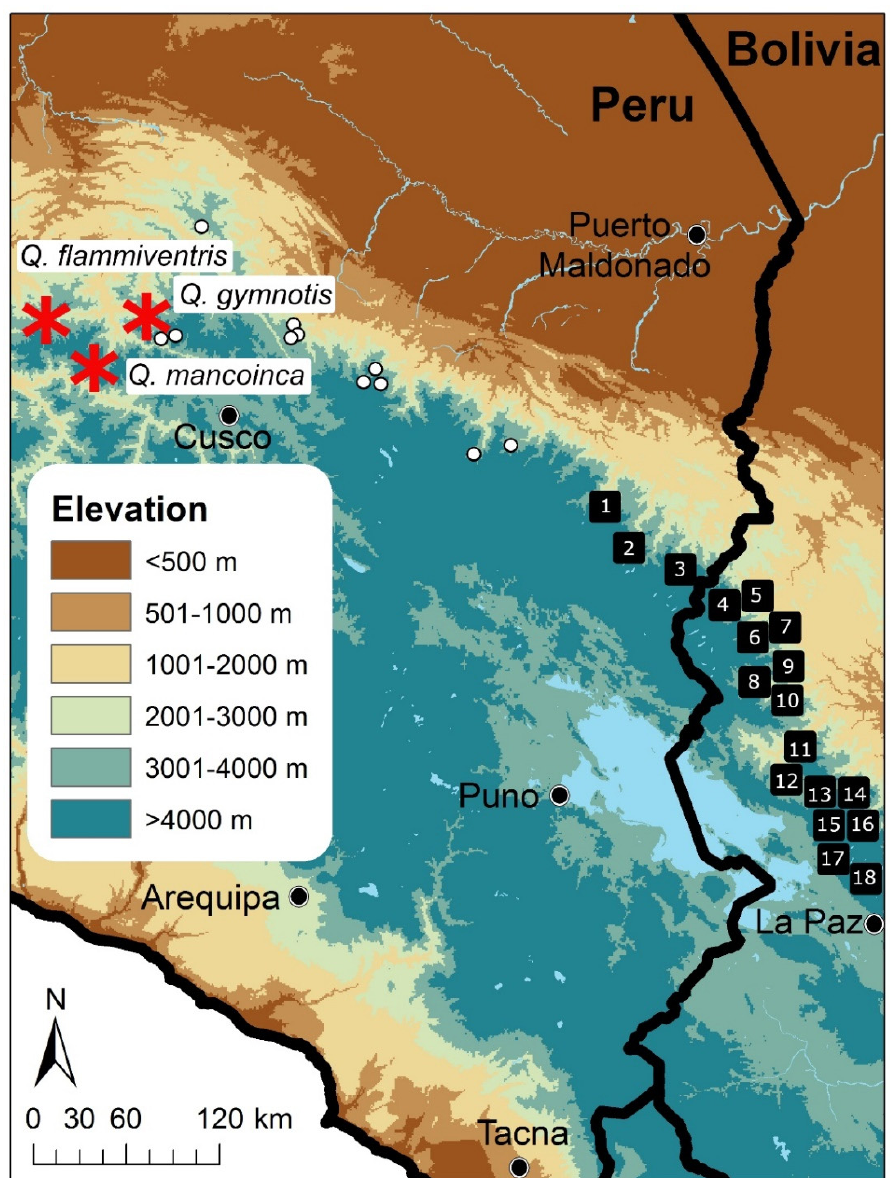
Figure 3. Type localities of frogs in the genera Bryophryne (white circles, species details not shown), Microkayla (squares) and Qosqophryne gen. n. (red asterisks) in southern Peru and northern Bolivia. The known distribution range of these frogs is limited to the type locality and immediate surroundings. For species of Microkayla : (1) M. boettgeri ; (2) M. chilina ; (3) M. chapi ; (4) M. katantika ; (5) M. chaupi ; (6) M. melanocheira ; (7) M. colla ; (8) M. kallawaya ; (9) M. guillei ; (10) M. saltator ; (11) M. iani ; (12) M. illampu ; (13) M. ankohuma ; (14) M. condoriri ; (15) M. teqta ; (16) M. huayna ; (17) M. chacaltaya ; (18) M. wettsteini . The map does not include seven species of Microkayla distributed in central and southern Bolivia (type localities outside the limits of this map).